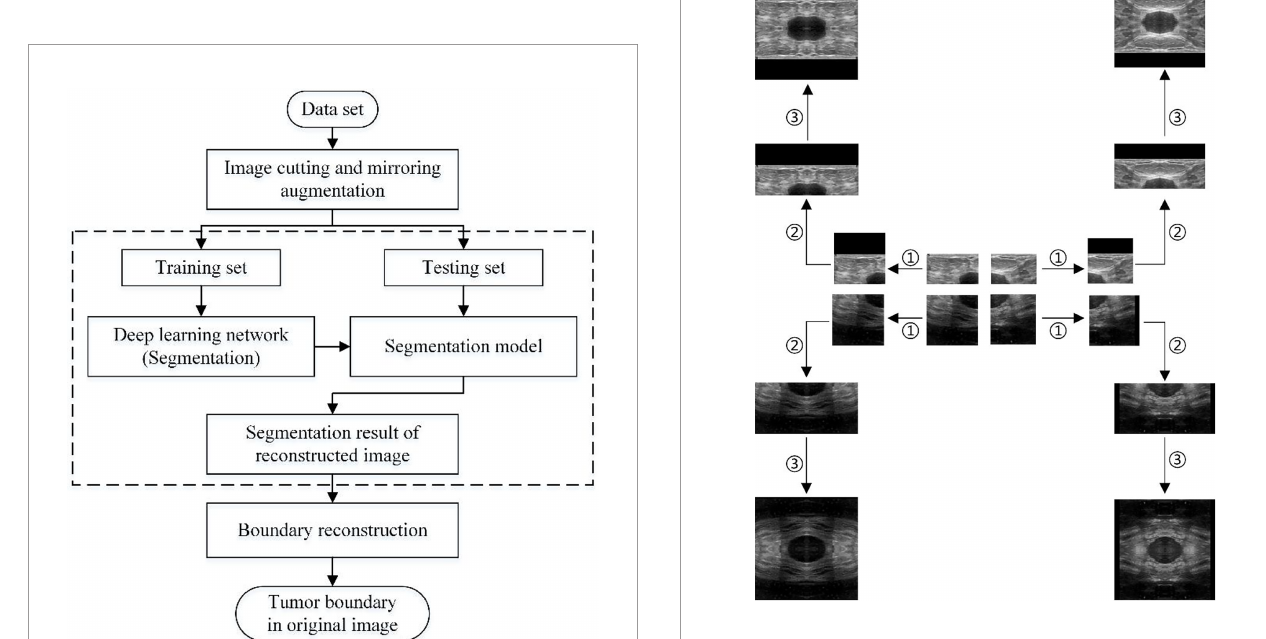
FIGURE 2 | Augmentation by horizontal and vertical mirroring around the approximate tumor center. ① fi lling background of the cut image, ② horizontal mirroring, ③ vertical mirroring.